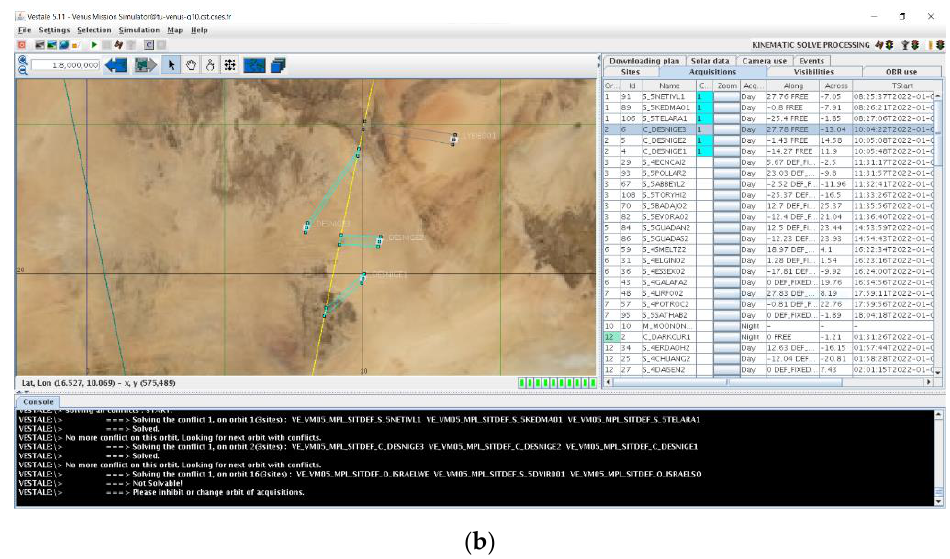
Figure 33. ( a ) VESTALE simulation for one site; ( b ) VESTALE simulation for another site.